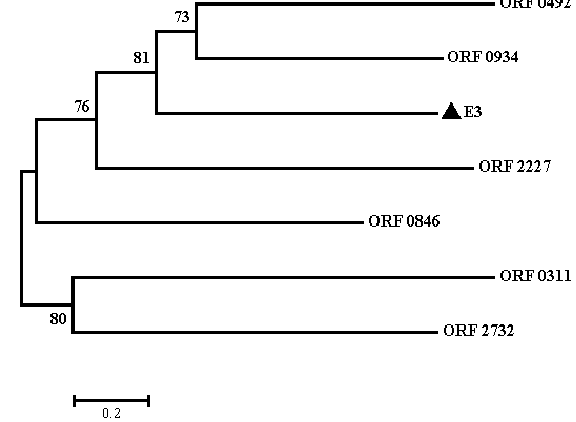
Figure 5. The conserved pentapeptide sequences (as highlighted in the red box) of E3 and six open reading frames (ORFs) from K. pneumoniae 2N3 (ORFs 2732, 2227, 0934, 0846, 0492, and 0311). The numbers at both ends of the amino acid sequences indicate the positions of the amino acids in the sequences, and the numbers in brackets indicate the number of amino acids omitted in the alignments.